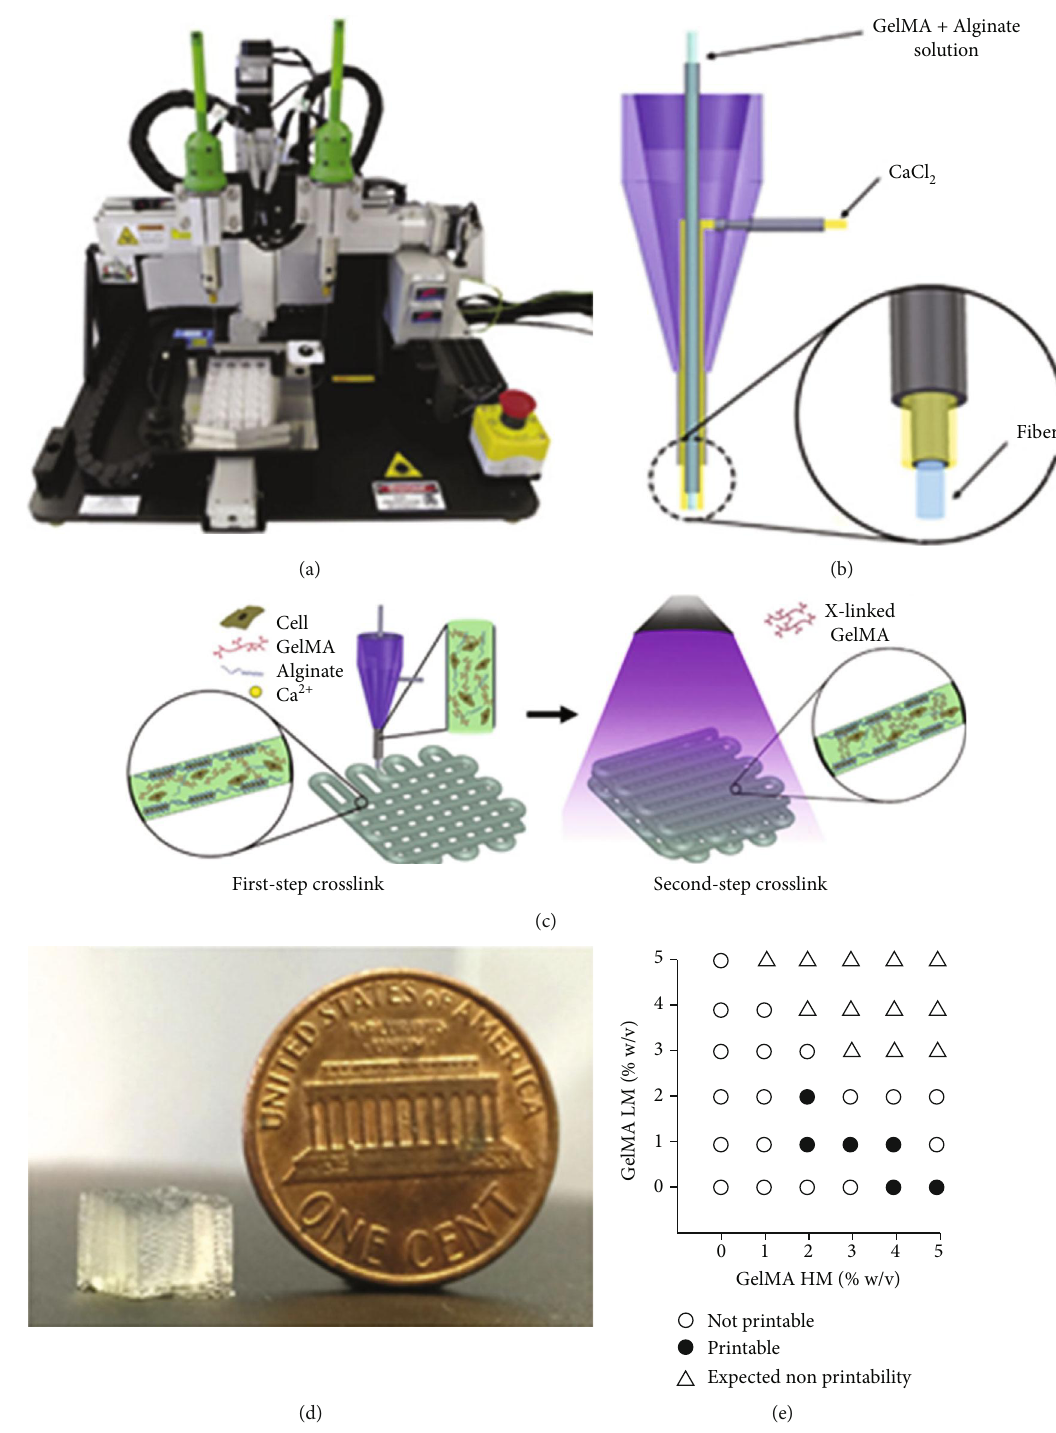
Figure 16: (a) Organovo Novogen MMX bioprinter. (b) Schematic of the coaxial needle where the bioink is delivered from the core, and the solution is sheathed on the side. (c) Schematic diagrams showing the two-step crosslinking process, with CaCl ionic crosslinking CaCl 2 followed by UV illumination. (d) Photograph of a bioprinted cubic micro fi brous sca ff old. (e) Bioink optimization where conditions of printability and nonprintability for di ff erent concentrations of GelMA-HM and GelMA-LM were analyzed. Reproduced (or adapted) with permission [56], ©2016,